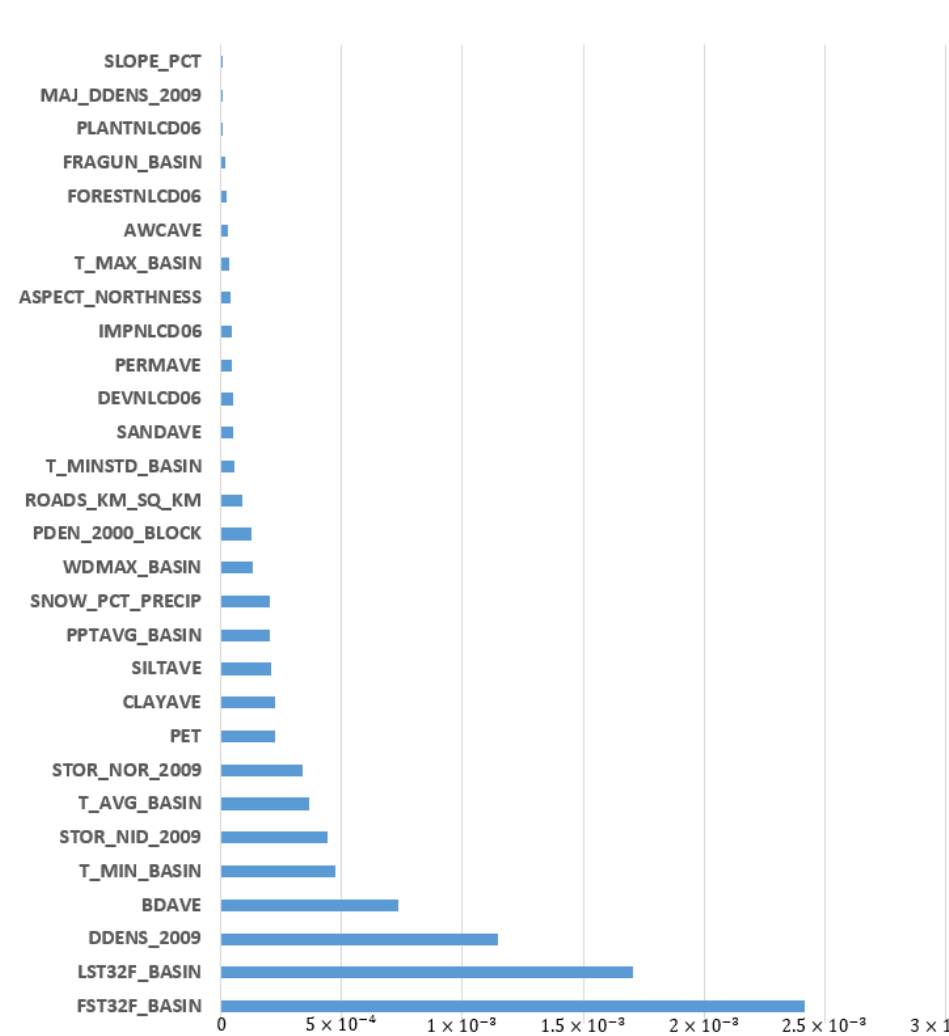
Figure 5. Predictor variables of the shape parameters (with associated importance) for Interior Highland. Description of predictor variables is provided in Appendix A.